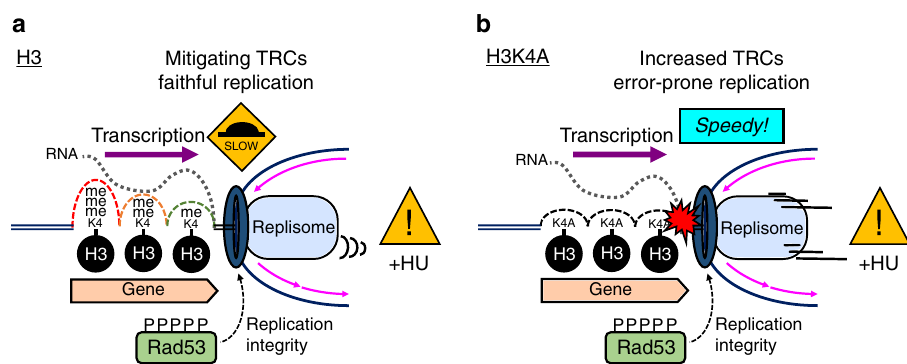
Fig. 8 Model for the effect of H3K4 methylation in relieving transcription-replication con fl icts. a Upon HU-stress, the S-phase checkpoint kinase Rad53 is activated to stabilize replication fork integrity; meanwhile, transcription-deposited H3K4 methylation acts as a series of speed bumps to decelerate fork progression, relieving transcription-replication con fl icts to reduce DNA damage at highly transcribed regions. b Conversely, without H3K4